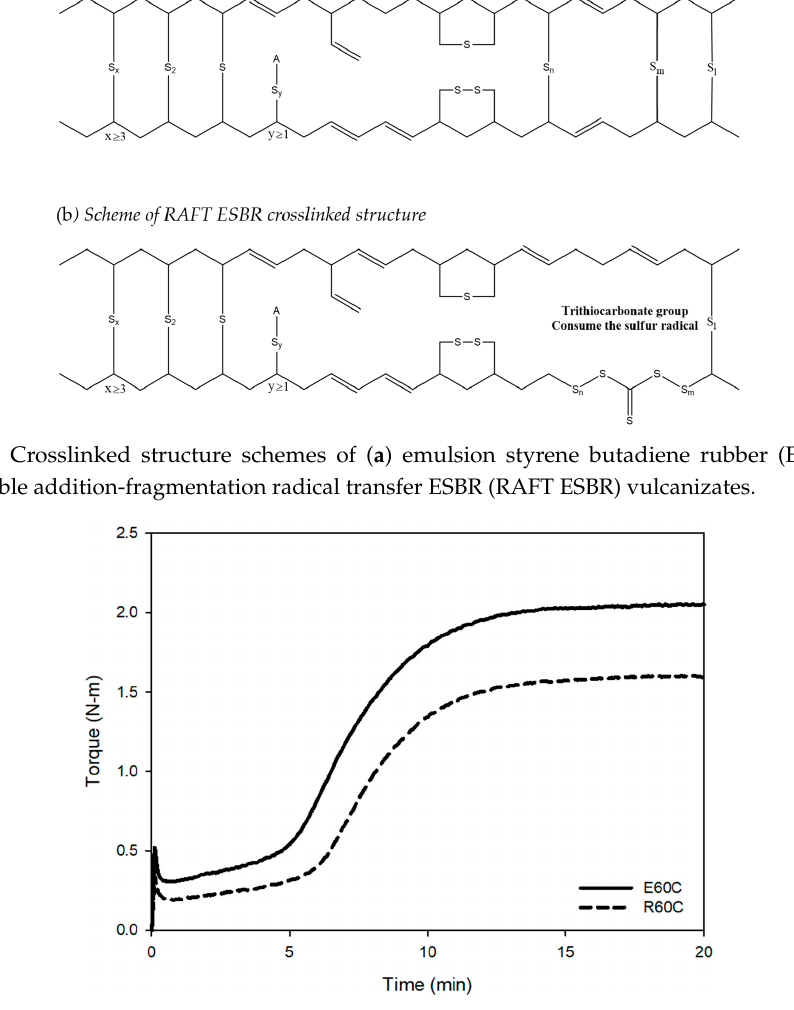
Figure 7. Crosslink densities of vulcanizates of emulsion styrene butadiene rubber (ESBR) and reversible addition ‐ fragmentation radical transfer (RAFT) ESBR carbon black ‐ filled compounds.